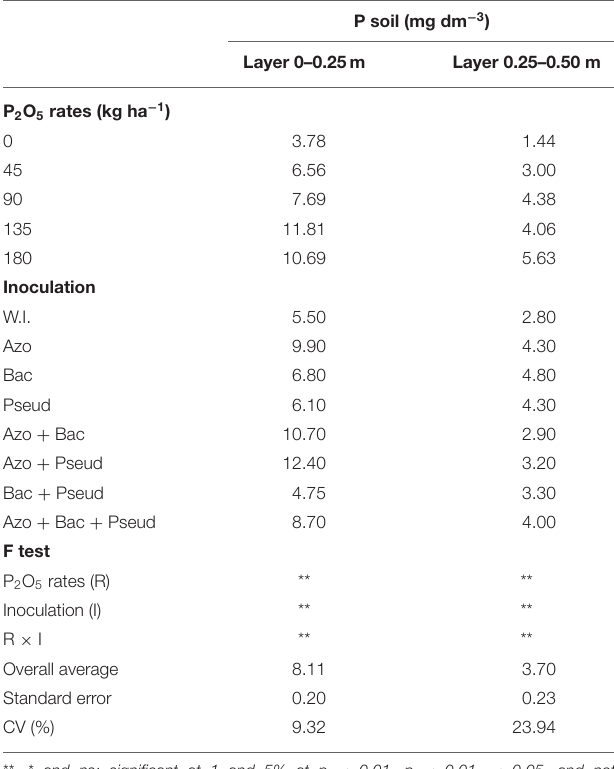
Standard error 0.51 Averages followed by the same letter in the column do not differ statistically by the Scott-Knott test at 5%